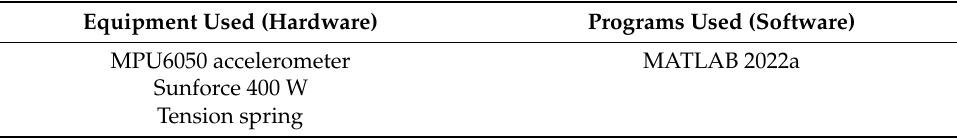
Table 1. Materials used in the